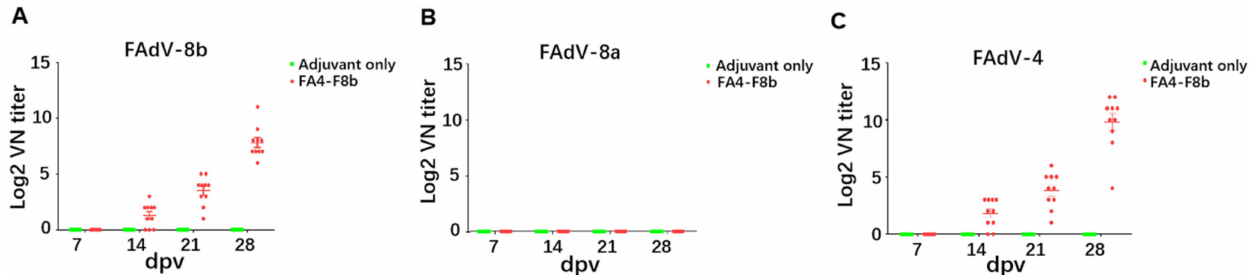
Figure 3. Inactivated FA4-F8b induced efficient neutralizing antibodies against both FAdV-4 and FAdV-8b. The neutralizing activity (NT) of sera against FAdV-8b ( A ), FAdV-8a ( B ), and FAdV-4 ( C ) from the inoculated chickens were tested at 7, 14, 21 and 28 dpv, and then these chickens at 28 dpv were infected with FAdV-8b, FAdV-8a and FAdV-4 at 28 dpv,